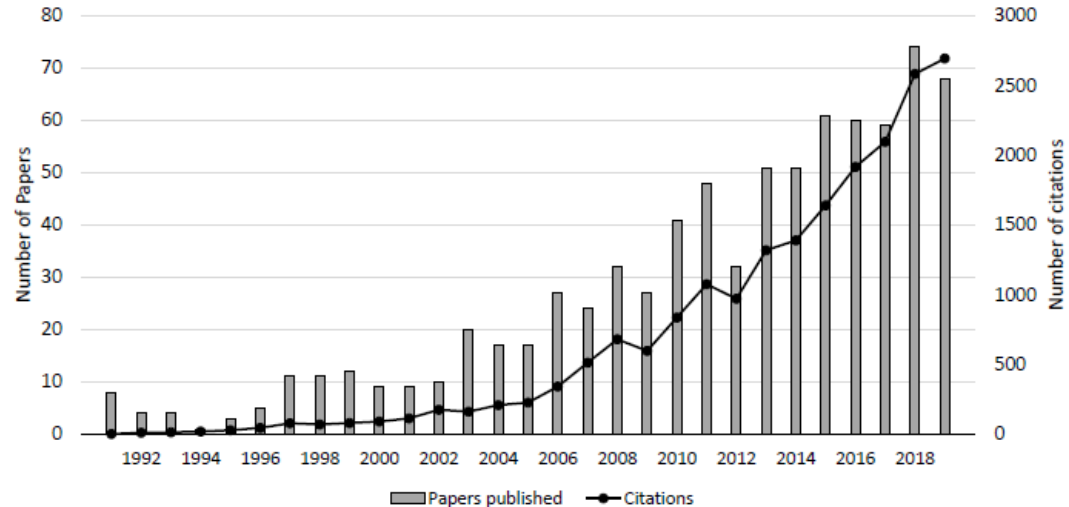
Figure 2. Number of peer-reviewed publications and citations on beach groundwater systems. The counts were obtained by conducting a search using the keywords “beach aquifer” and “subterranean estuary” using the Web of Science database. From 1991 to 2019, a total of 796 papers have been published totaling 19,988 citations.